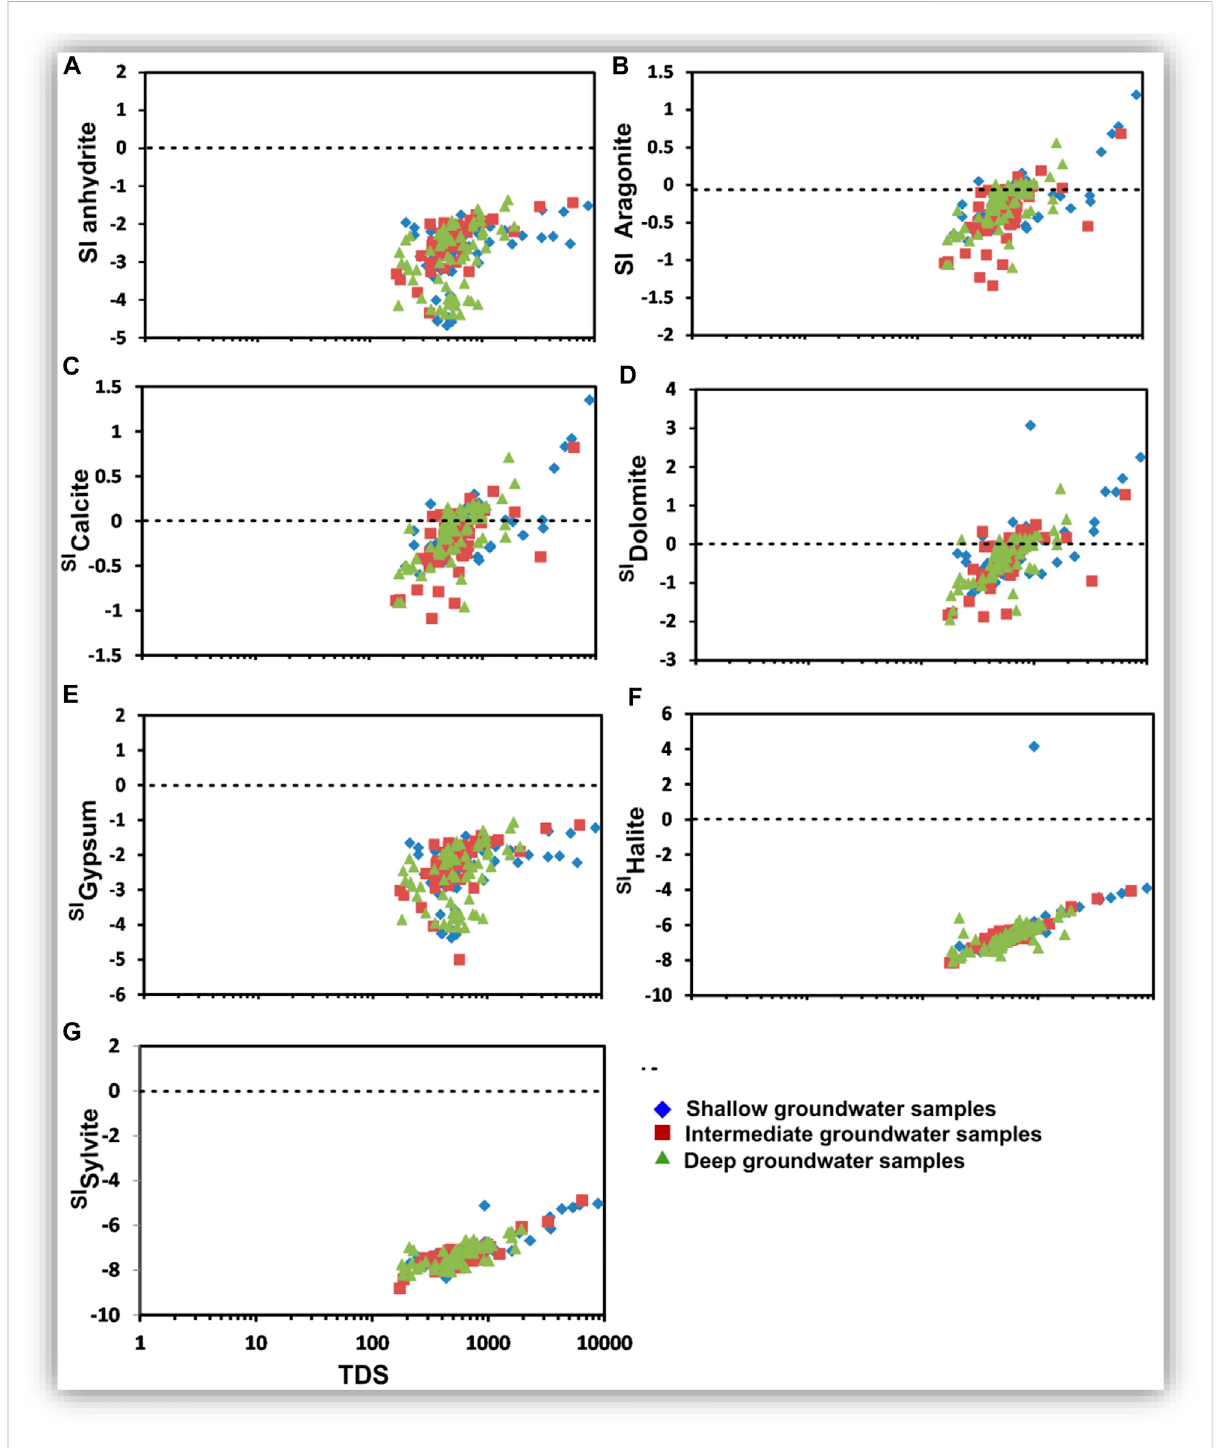
FIGURE 12 Relationships between TDS (mg/l) and the saturation indices of the dissolved minerals in the shallow, intermediate, and deep groundwater.